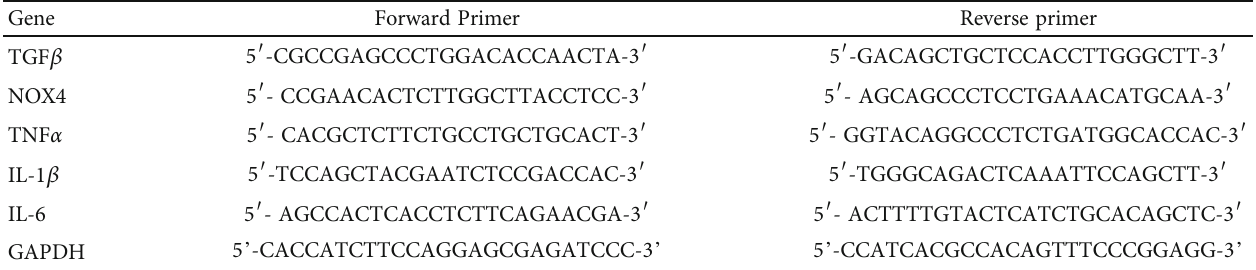
Table 1: Primers used for quantitative real-time PCR